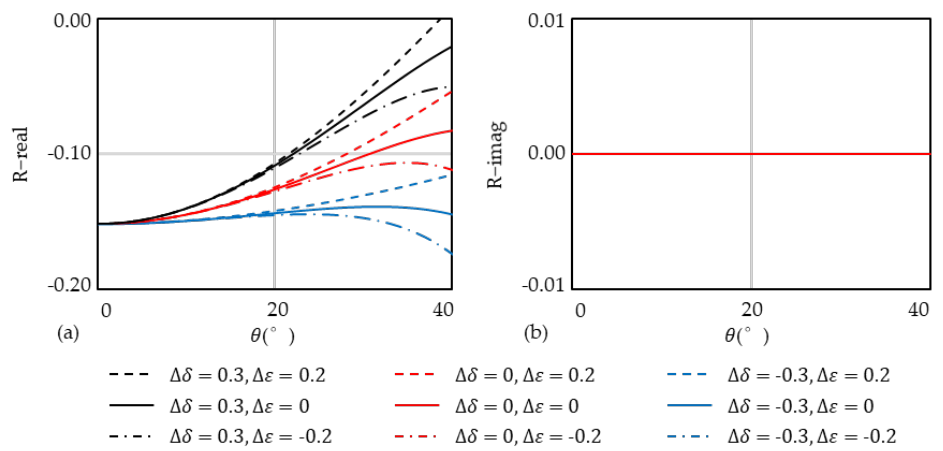
Figure 4. The effect of anisotropic parameters ∆ ε and ∆ δ on the reflection coefficients. At this point, the reflection coefficients are real numbers and frequency-independent. ( a ) shows the real part of it in nine combinations of anisotropy parameters, and ( b ) shows the imaginary part equal to zero.